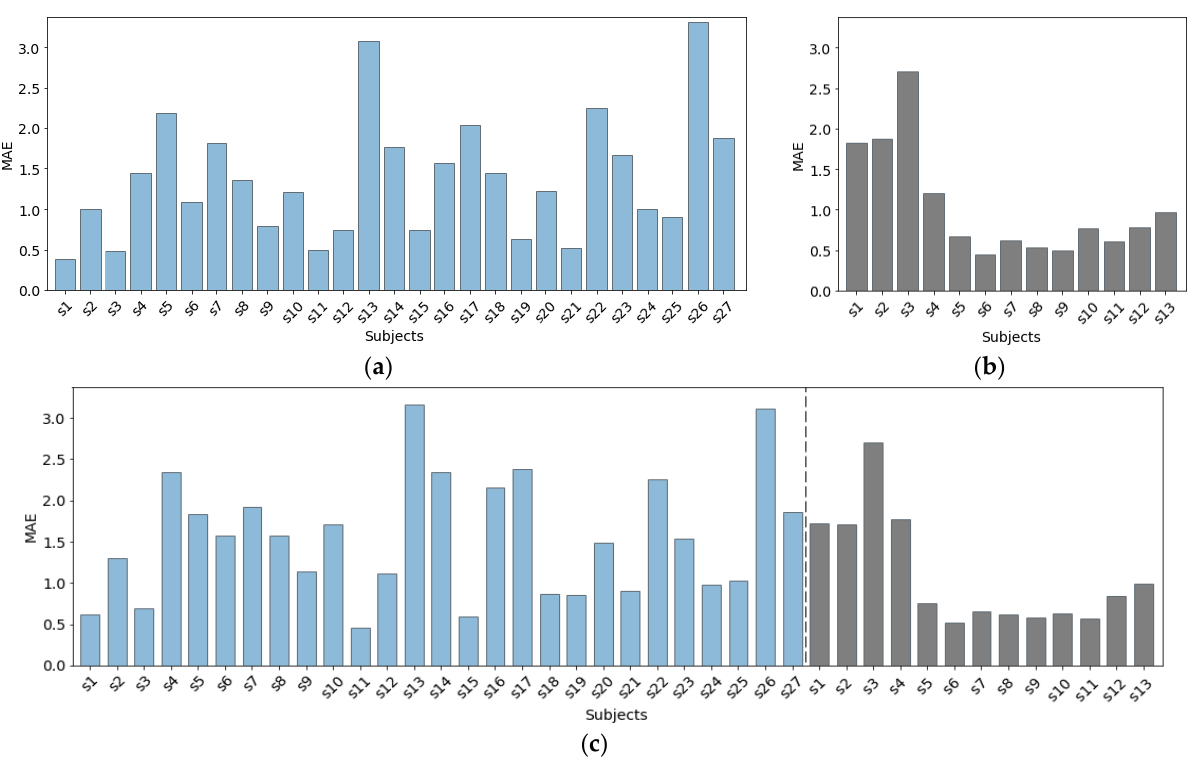
Figure 9. Average mean absolute error (MAE) per subject, interpretable in breaths per minute, achieved with the proposed method using leave-one-subject-out (LOSO) cross-validation on: ( a ) Dataset 1; ( b ) Dataset 2; ( c ) Dataset 1 + Dataset 2.